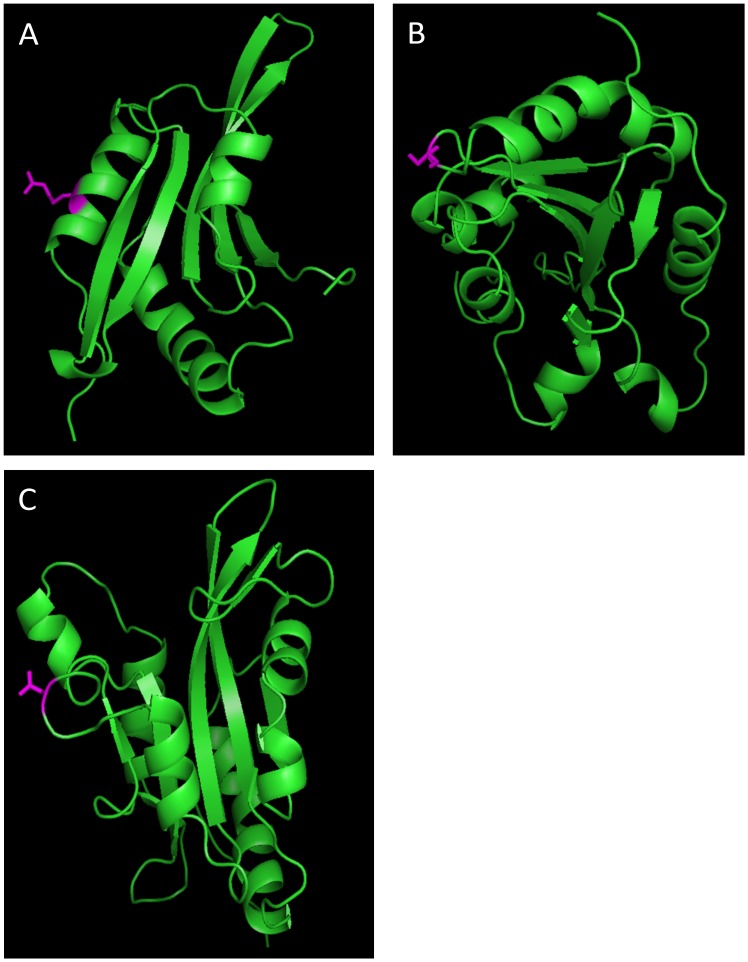
Three dimensional protein models of ADF/CFL proteins highlighting sites with accelerated rates of evolution (ω3 rate category) in pink.(A) Z. mays ADF5 proteins with codon position 26 highlighted. (B) H. sapiens CFL1 protein with codon position 125 highlighted. (C) D. rerio CFL2 protein with codon position 69 highlighted.